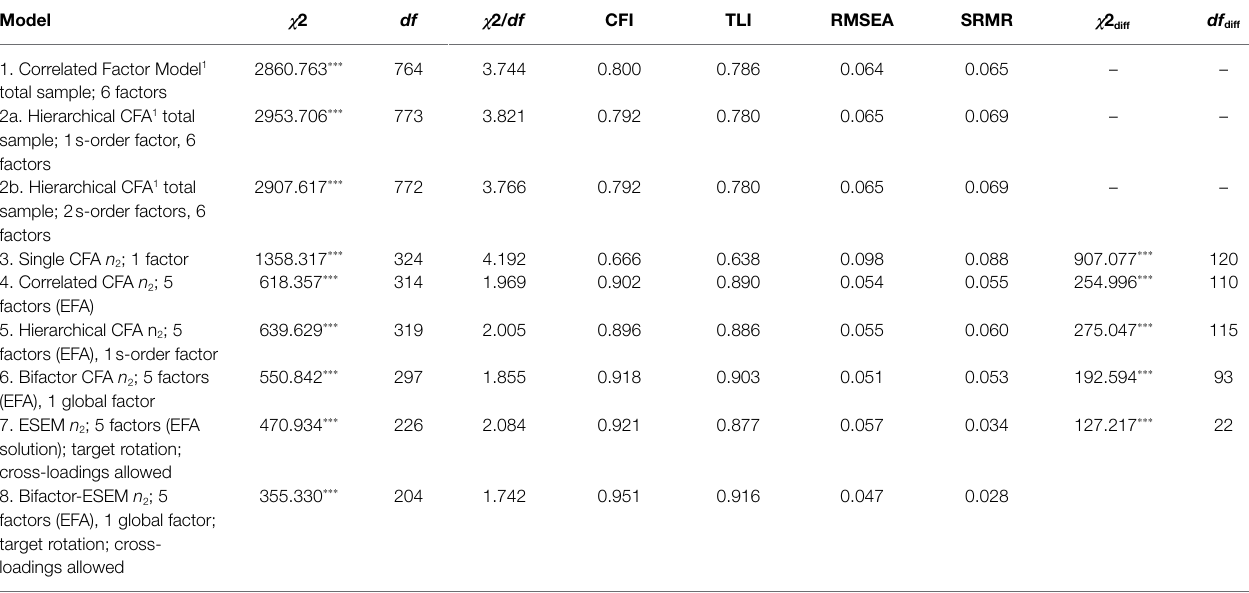
TABLE 2 | Goodness-of-fit statistics for competing factor structure models of the Counselor Activity Self-Efficacy Scales-Revised (CASES-R).